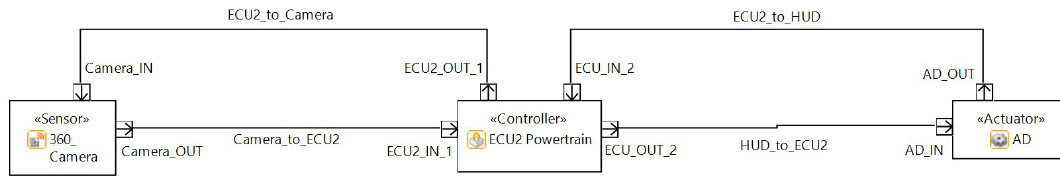
Figure 6. Realization of ECU1 Traditional Architecture in Ansys Medini Analyze.